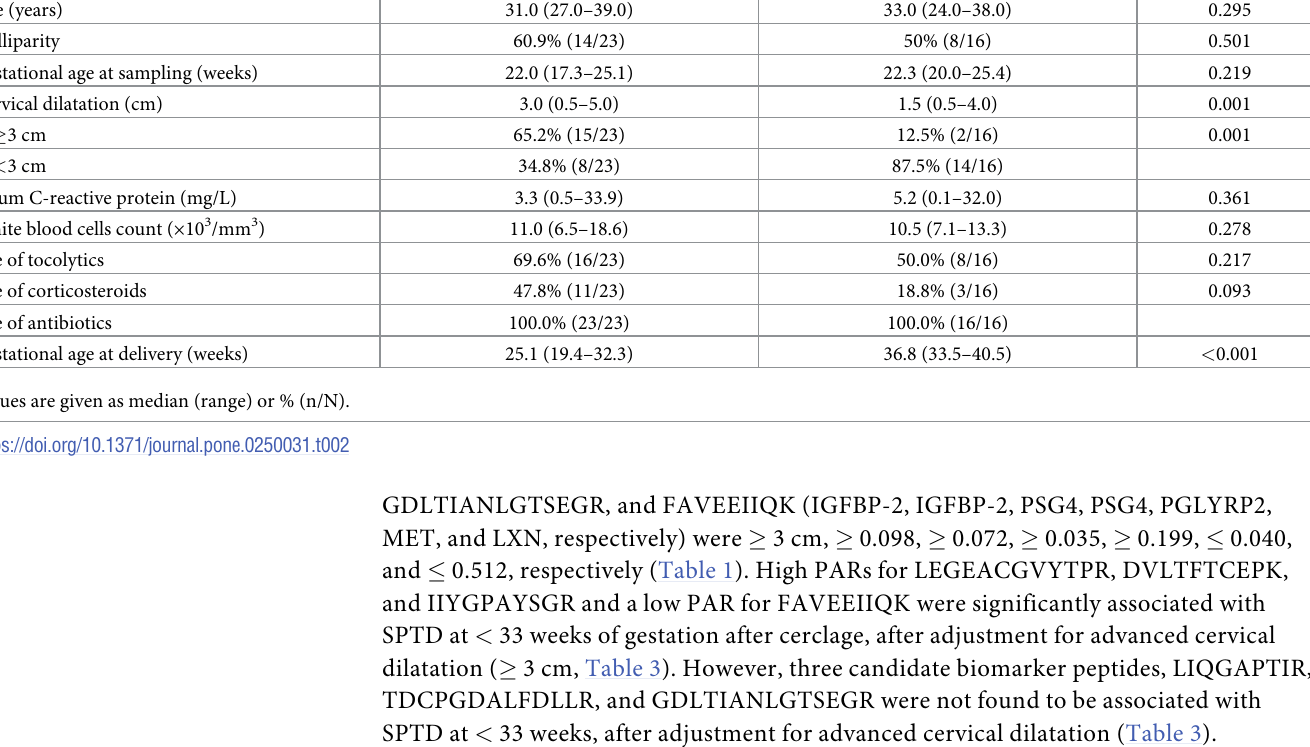
Table 2. Demographic and clinical characteristics of women involved in the final cohort.